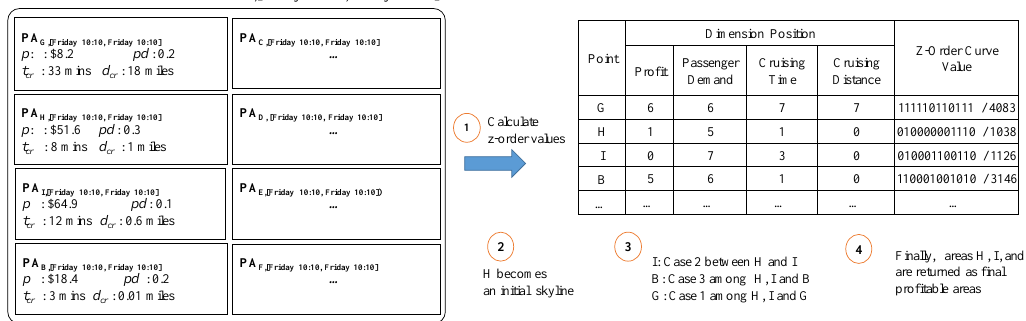
Figure 21. An example of profitable-area query